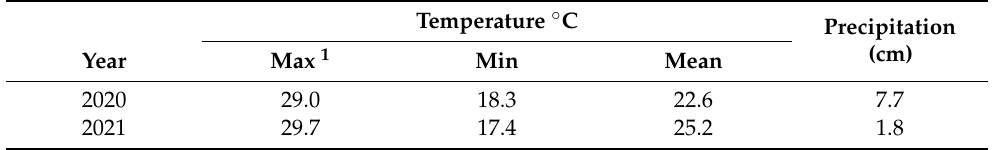
Table 1. Mean daily temperature ( ◦ C), minimum temperature ( ◦ C), maximum temperatures ( ◦ C), and total precipitation (cm) throughout the study period during the summers of 2020 and 2021 at Whitethorne Agroforestry Demonstration Center, Blacksburg, VA,